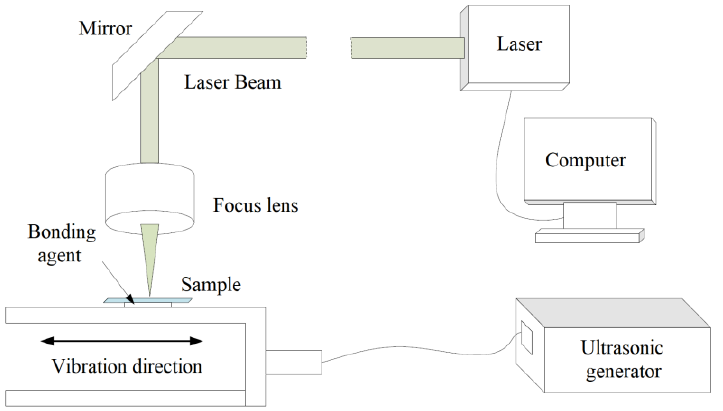
Figure 12. Schematic of ultrasonic vibration-assisted laser composite machining of copper for superhydrophobicity [70].